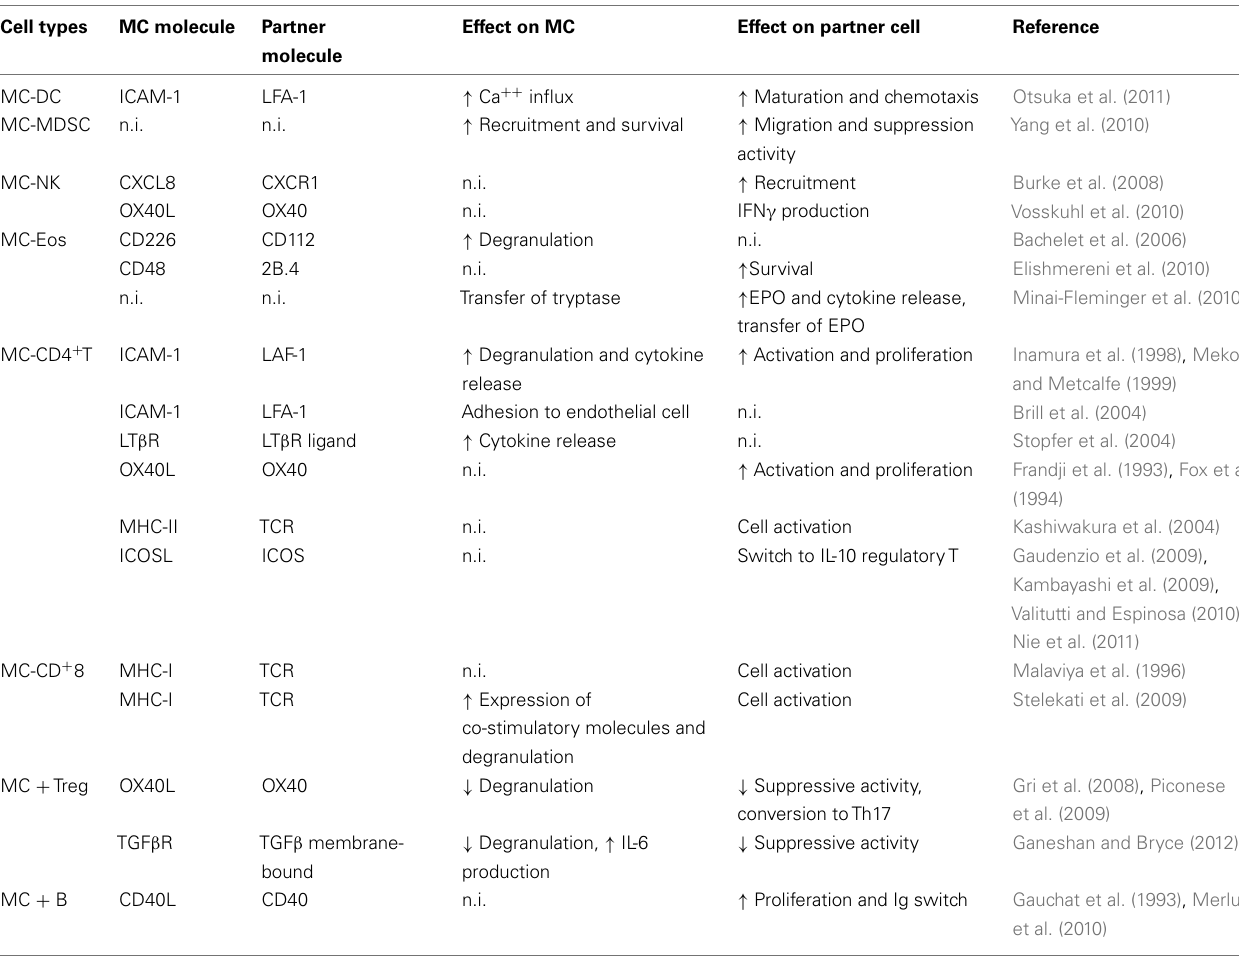
Table 3 | MC physical interactions with other immune